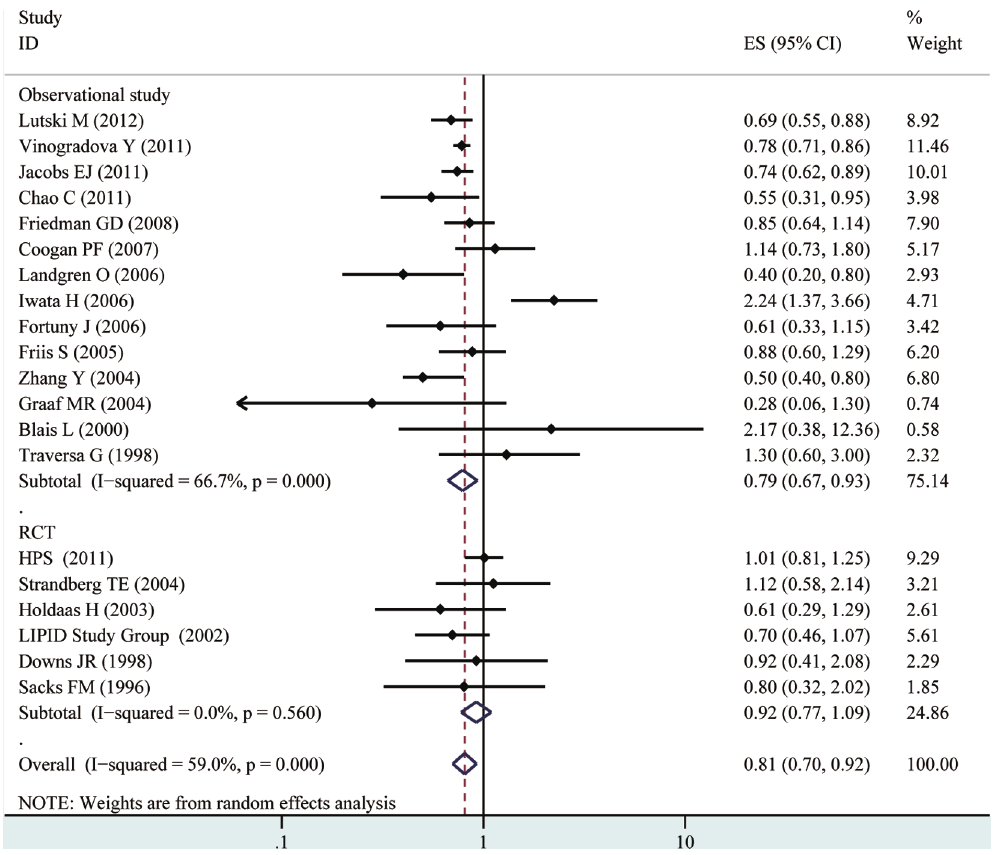
Figure 2. Forest plot: estimates (95% CIs) of statin use and risk of haematological malignancies. Squares indicated study-specific risk estimates (size of square reflects the study-statistical weight, i.e. inverse of variance); horizontal lines indicate 95% confidence intervals; diamond indicates summary relative risk estimate with its corresponding 95% confidence interval.